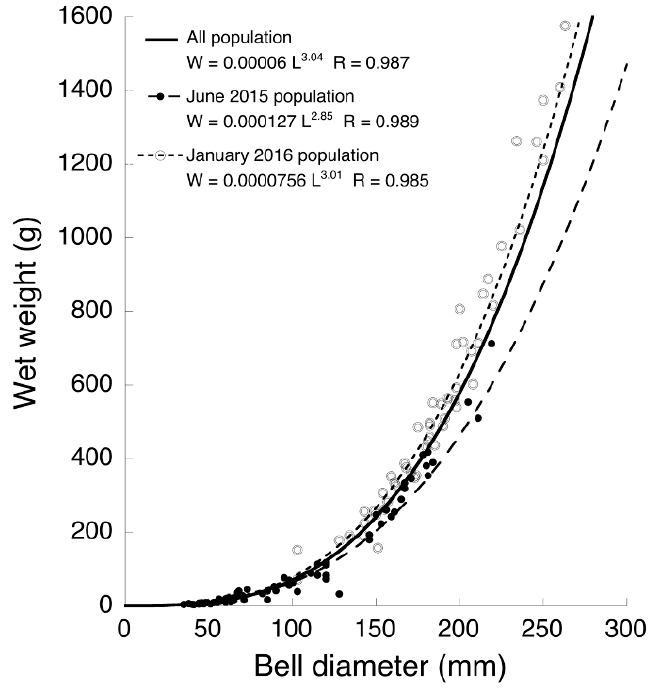
Figure 6. Relationship between bell diameter and wet weight of Acromitus hardenbergi medusae collected in different sampling periods.